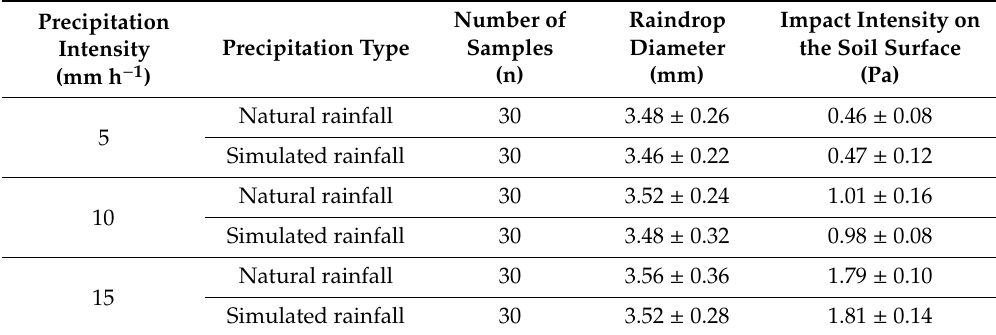
Table 1. Impact intensity of natural and simulated rainfall on the soil surface per